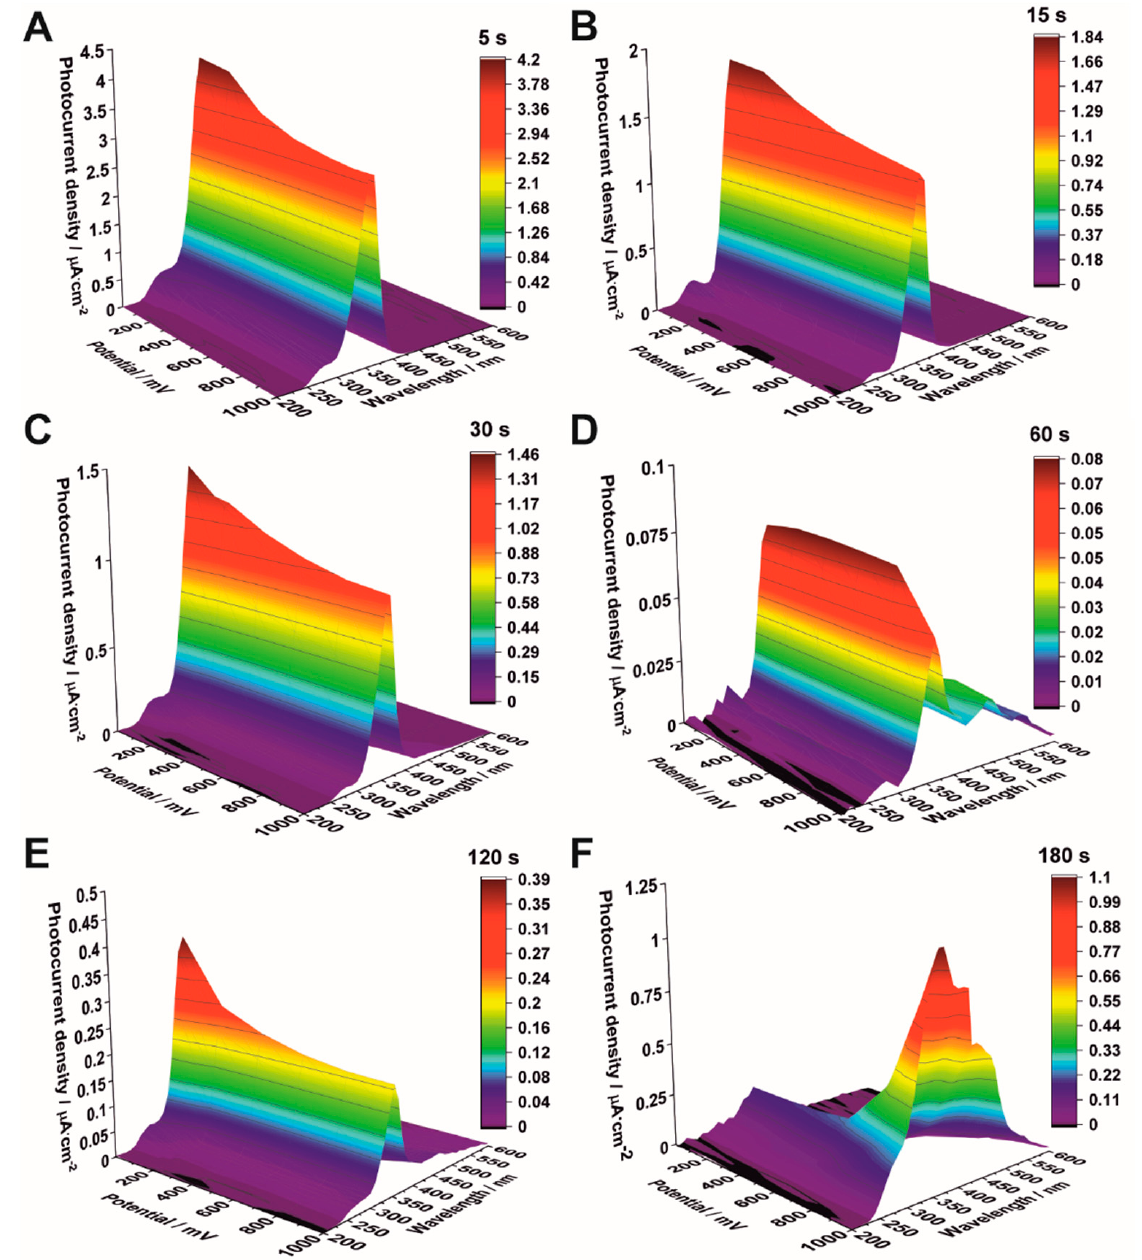
Figure 8. Photocurrent density vs. incident light wavelength and applied potential in 0.1 M KNO 3 for Fe 2 O 3 –TiO 2 samples obtained by electrodeposition for 5 s ( A ), 15 s ( B ), 30 s ( C ), 60 s ( D ), 120 s ( E ), and 180 s ( F ).